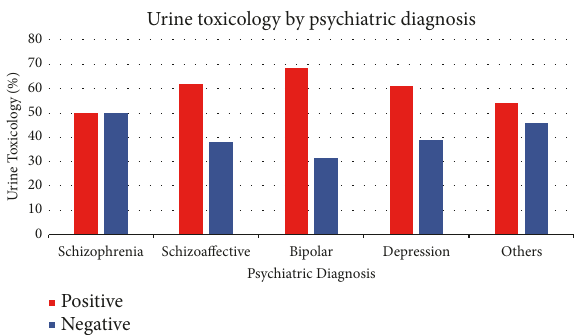
Figure 2: The distribution of urine toxicology report by psychiatric